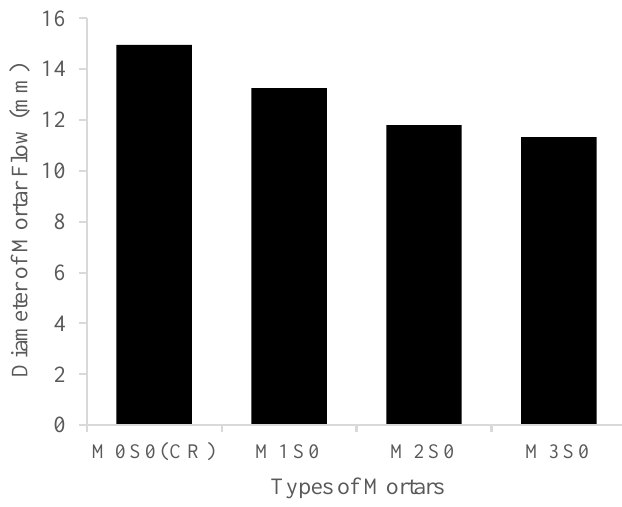
Figure 6. Effects of SDPMF content on the workability.